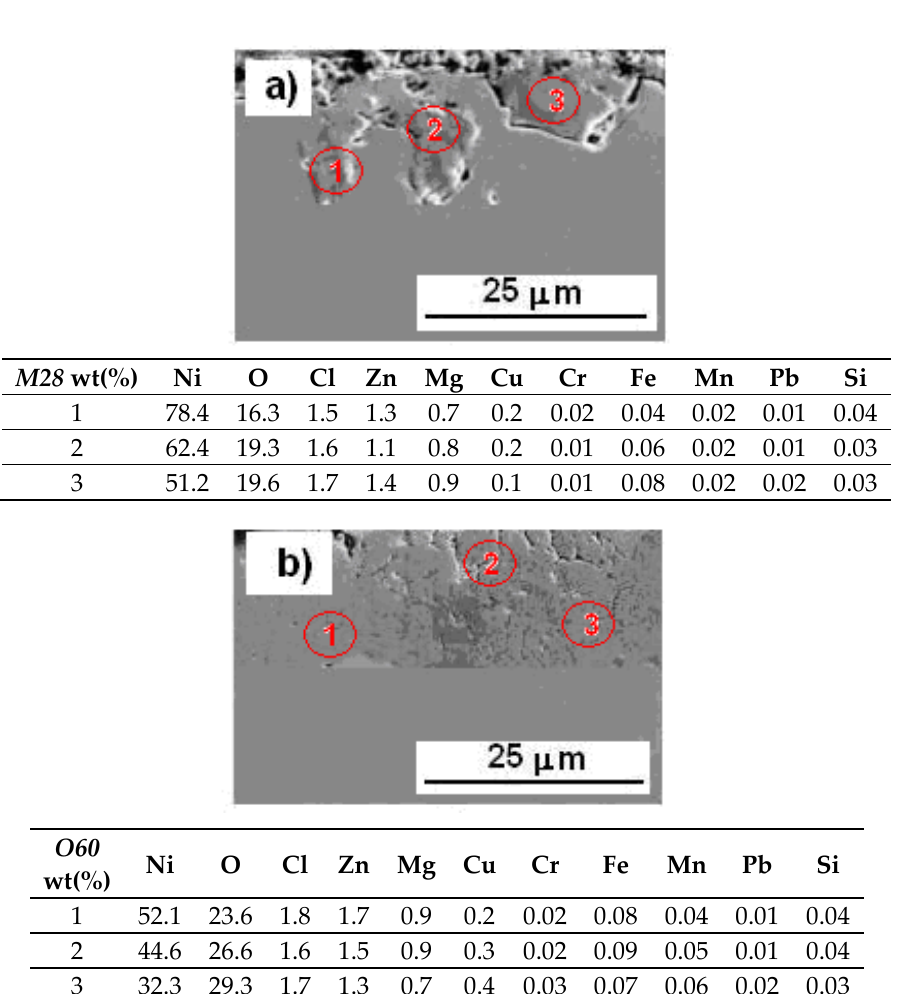
Figure 12. Surface corrosion products and their local SEM/EDS analyses obtained for: ( a ) M28 and ( b ) O60 nickel coatings after the corrosion test in 1.2 M Cl − , pH 1.5.